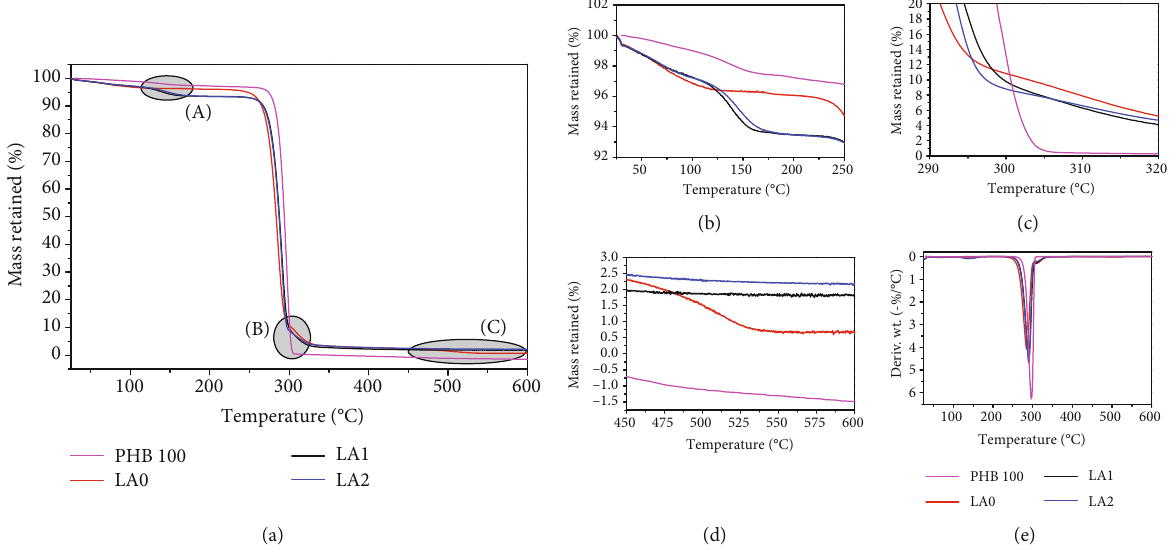
Figure 5: TGA and DTG curves of PHB/S/LA composites. (a) Full TGA curve. (b – d) Selected magni fi cations of 5A, at regions (a) 0 – 150 ° C, (b) 290 – 320 ° C, and (c) 450 – 600 ° C, respectively. (e) DTG curve. Table 4: TGA parameters of PHB/S/LA